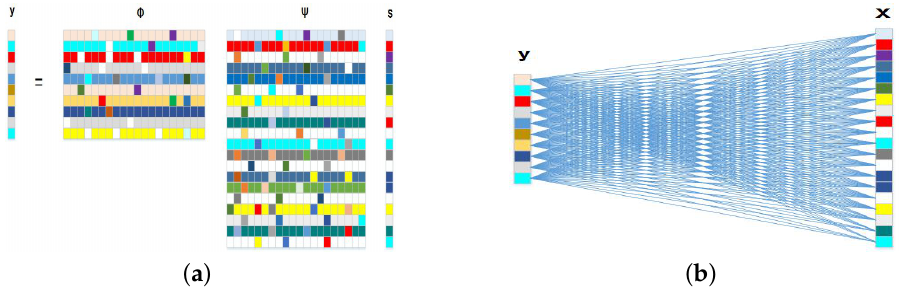
Figure 2. ( a ) Random Gaussian matrix is used as measurement matrix Φ . ( b ) The fully connected matrix is used as measurement matrix and the parameters are learned from training